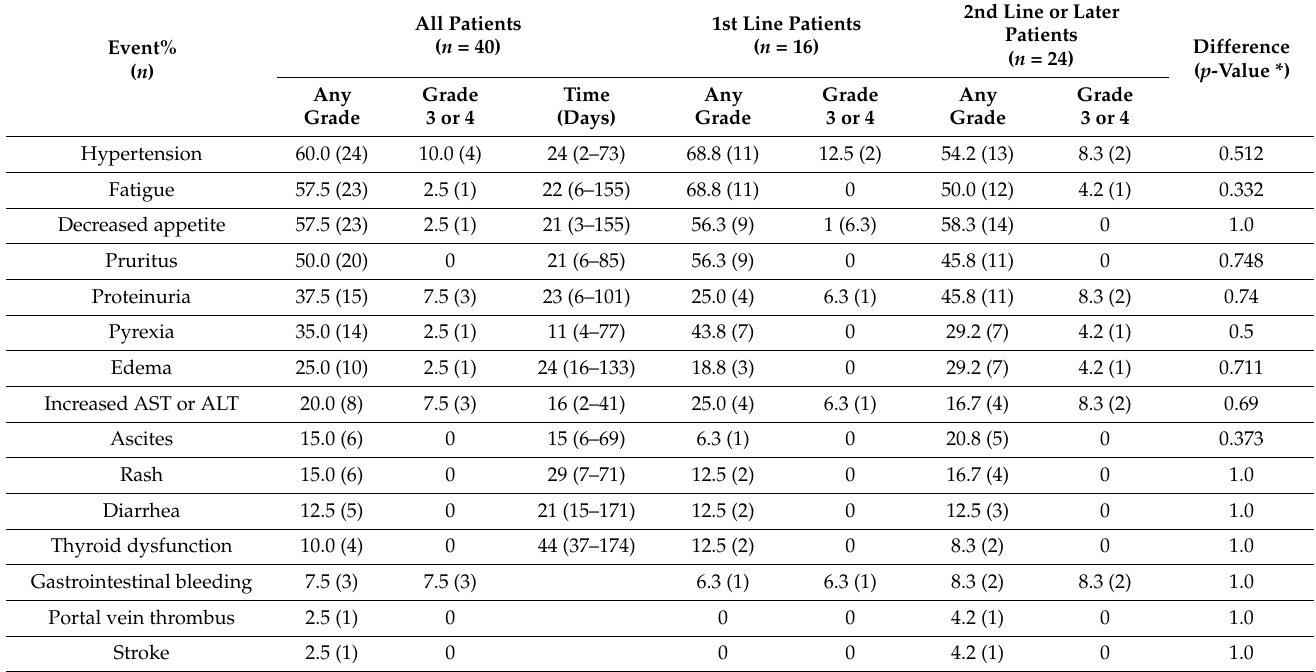
Table 5. Adverse events associated with treatment.